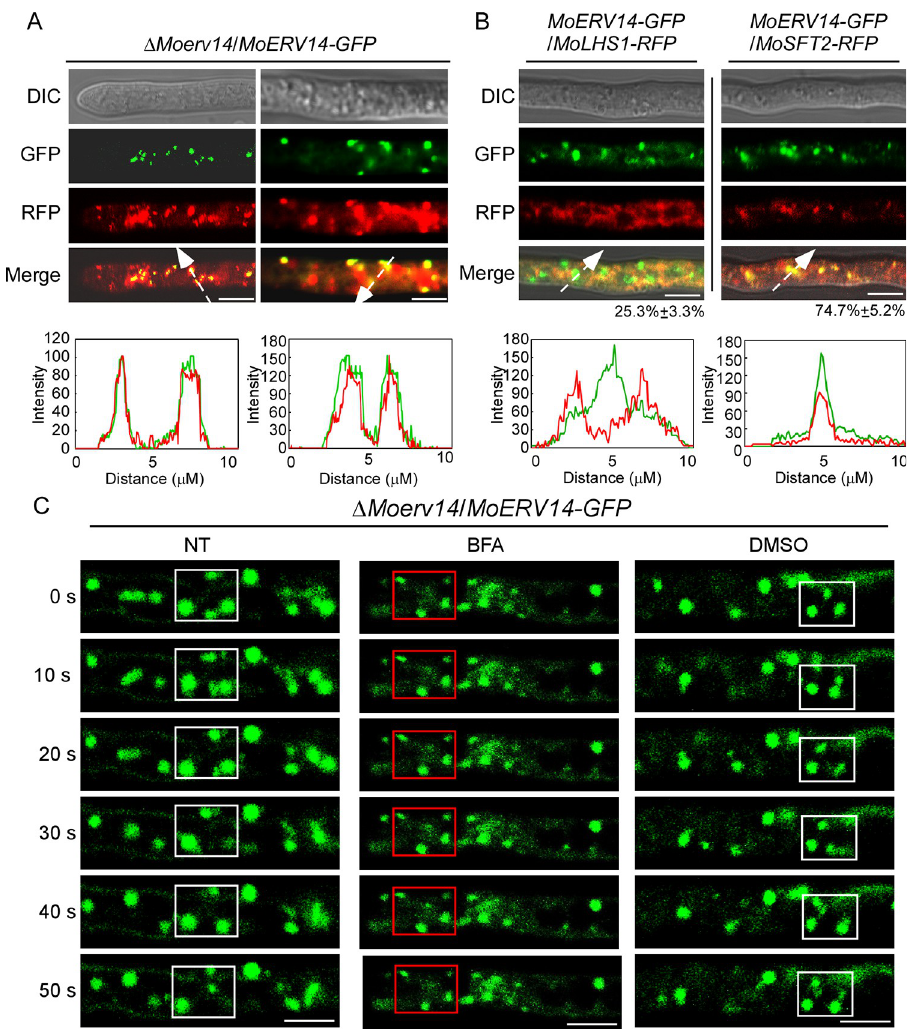
Fig 3. MoErv14 shuttles between ER to Golgi in M . oryzae . (A) MoErv14-GFP were expressed in Δ Moerv14 , then stained with FM4-64 for 3min and observed by Axio Observer A1 Zeiss inverted microscope. The left shown is the tip of the hypha and the right shown is the middle of the hyphae. Asterisks represent the labeled and merged vesicles. Bar = 10 nm. (B) The localization pattern of MoErv14 in the hypha. Shown are confocal fluorescent images (Zeiss LSM710, 63 × oil). Bar = 10 nm. (C) Time-lapse images of cells expressing the MoErv14-GFP reporter at different time intervals with or without the treatment of ER-Golgi protein trafficking inhibitor Brefeldin A (BFA), 50 μ g/ml, DMSO treatment was used as a control, Bar = 10 nm. White frames indicated dynamic MoErv14 and red frames indicated detained MoErv14.